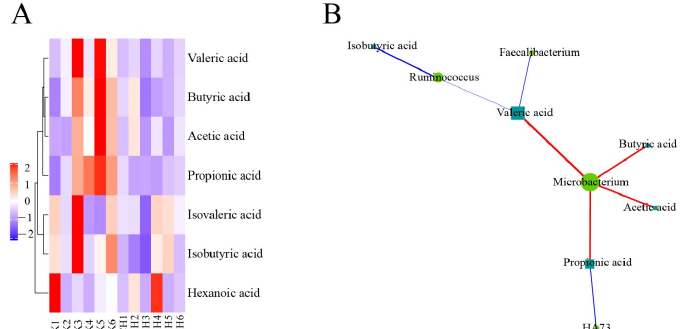
Figure 15. Correlation analysis of intestinal floras and SCFAs in chicken cecum contents between the normal control group and the intervention group of CASP. Note: ( A ) Cluster heatmap of SCFAs between the normal control group and the intervention group of CASP; ( B ) Network of intestinal floras and SCFAs between the normal control group and the intervention group of CASP. The red and blue line represents positive and negative correlation, respectively. The same as below.